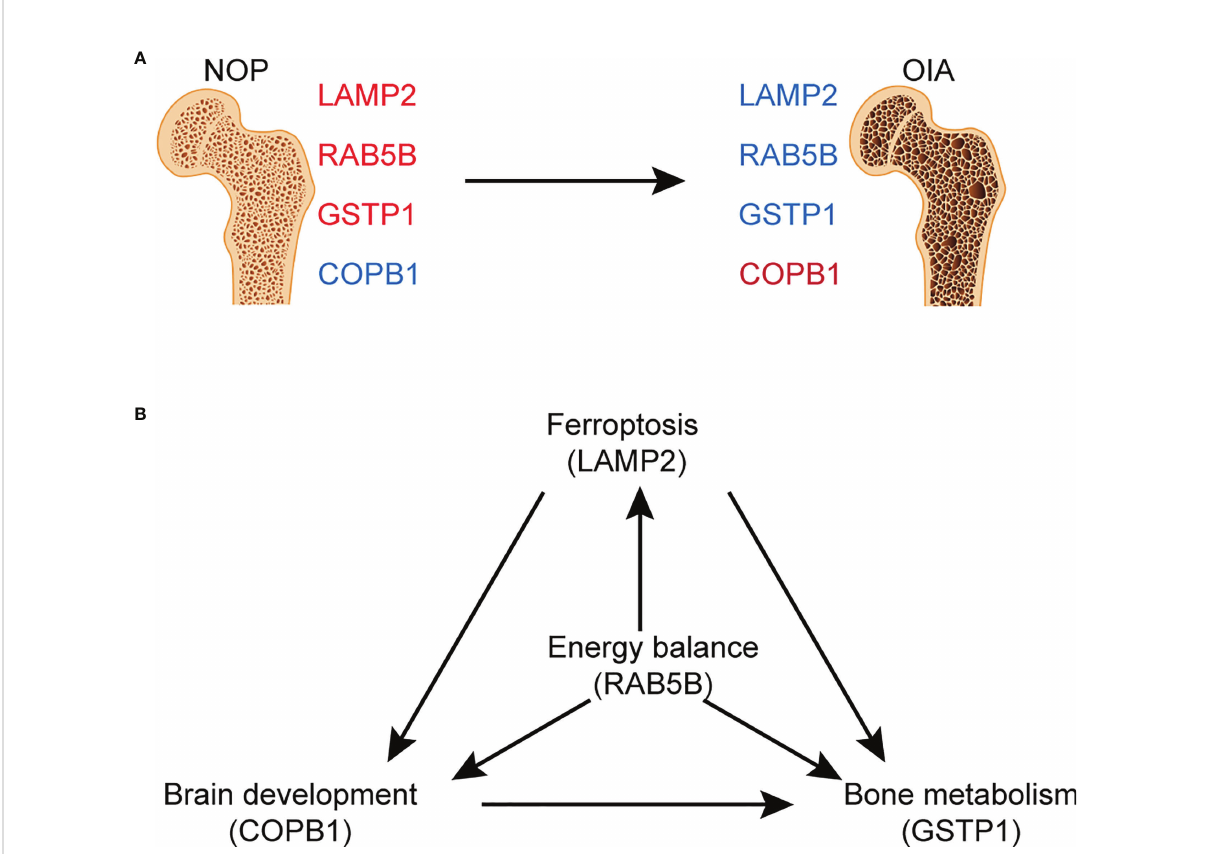
FIGURE 6 Graphed summary of four core proteins. (A) The changes of four core proteins between NOA and OIA. (B) The possible effects of four core proteins on the related